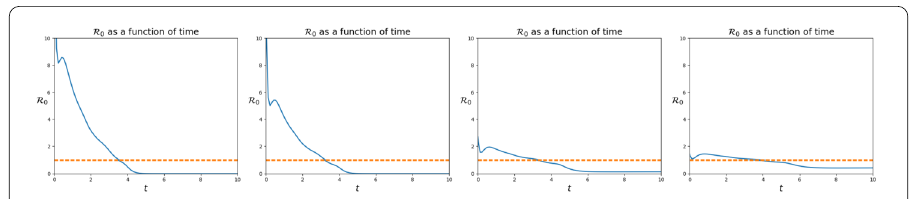
Figure 7 Value of the R 0 index, as defined in (6), as a function of time, according to (9), in the four cases, from left to right: κ = 0, κ as in (20), 10 κ and 20 κ . The effect of quarantine is evident: increasing values of κ result in longer periods where R 0 exceeds one, but with lower values of the index. This typically results in a more bearable stress on the health